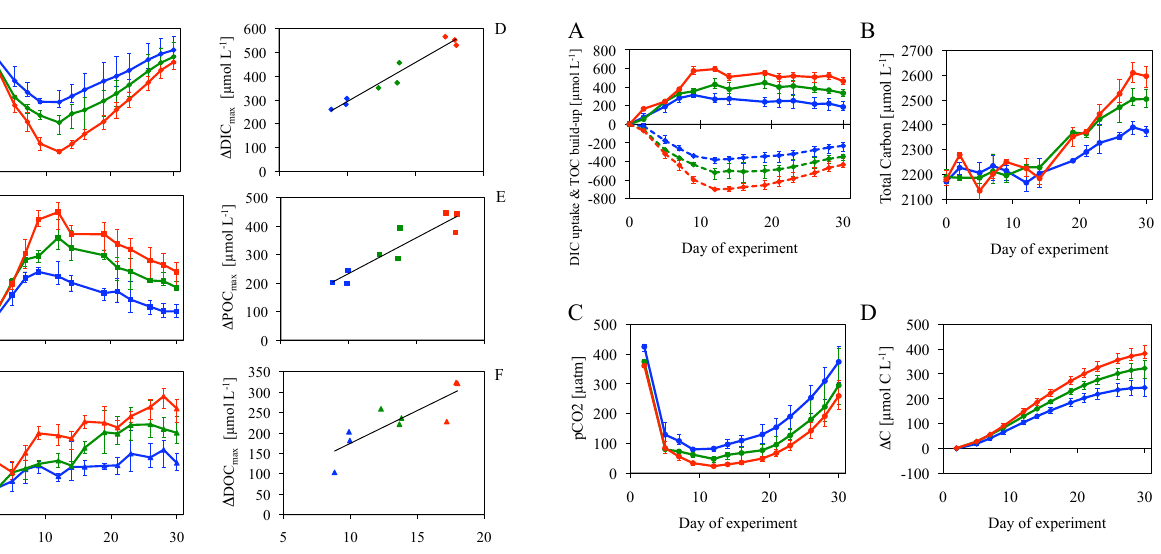
Fig. 4. Temporal development of (A) corrected (air–water gas ex- change) DIC uptake (dashed) and measured TOC build-up (solid), (B) measured total carbon concentrations, (C) calculated p CO 2 (water) in the mesocosms and (D) calculated cumulative air–water carbon flux into the mesososms. Style and color-coding follow that of Fig.